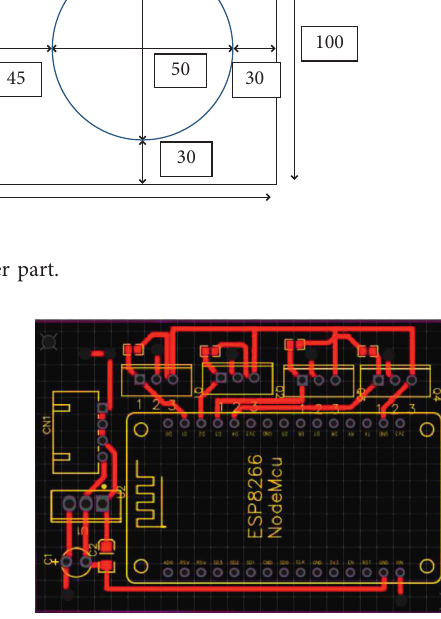
Figure 23: Schematic circuit diagram.